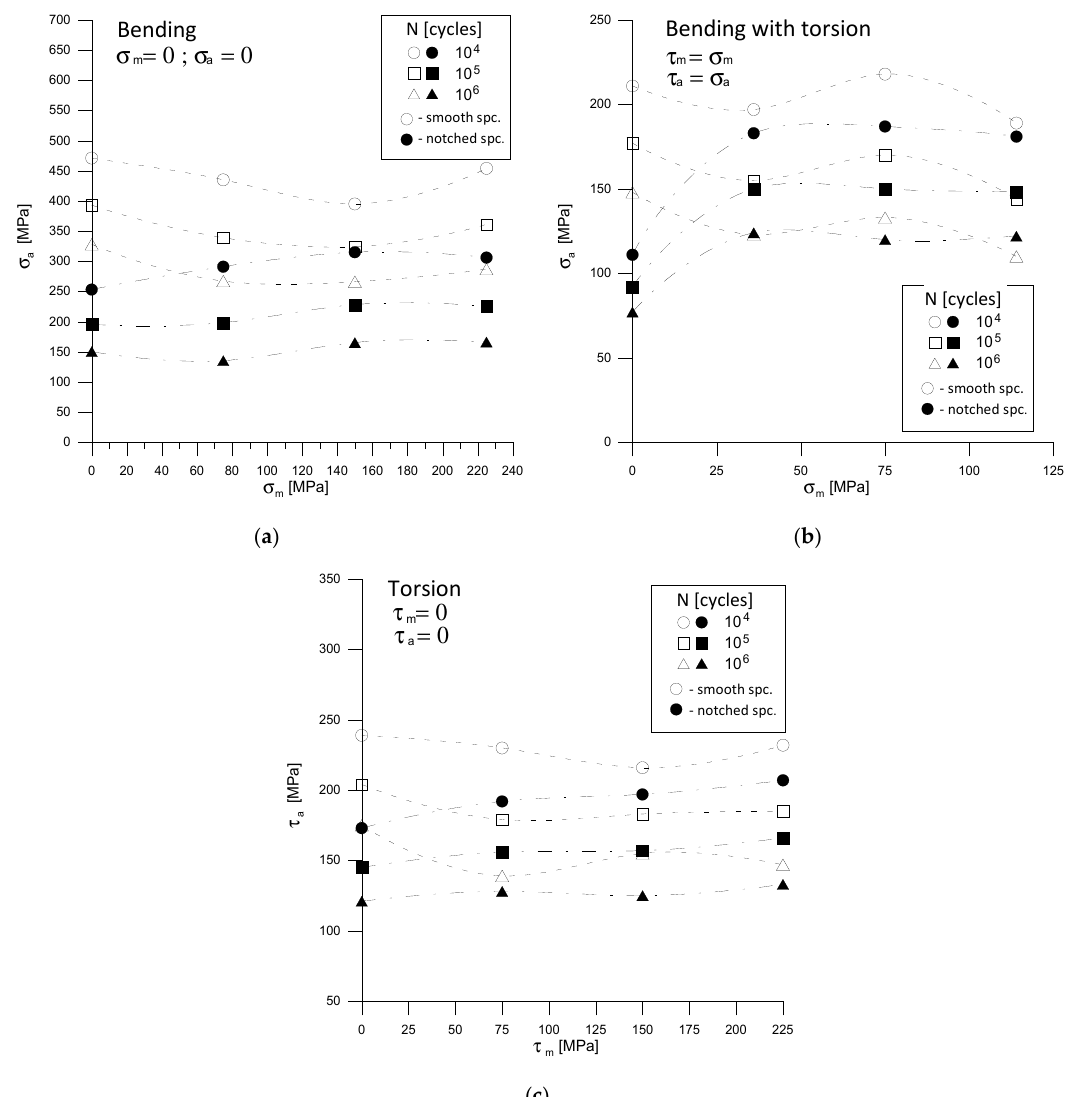
Figure 7. Influence of mean stress values on permissible stress amplitudes: ( a ) for bending, ( b ) for bending with torsion, ( c ) for torsion.